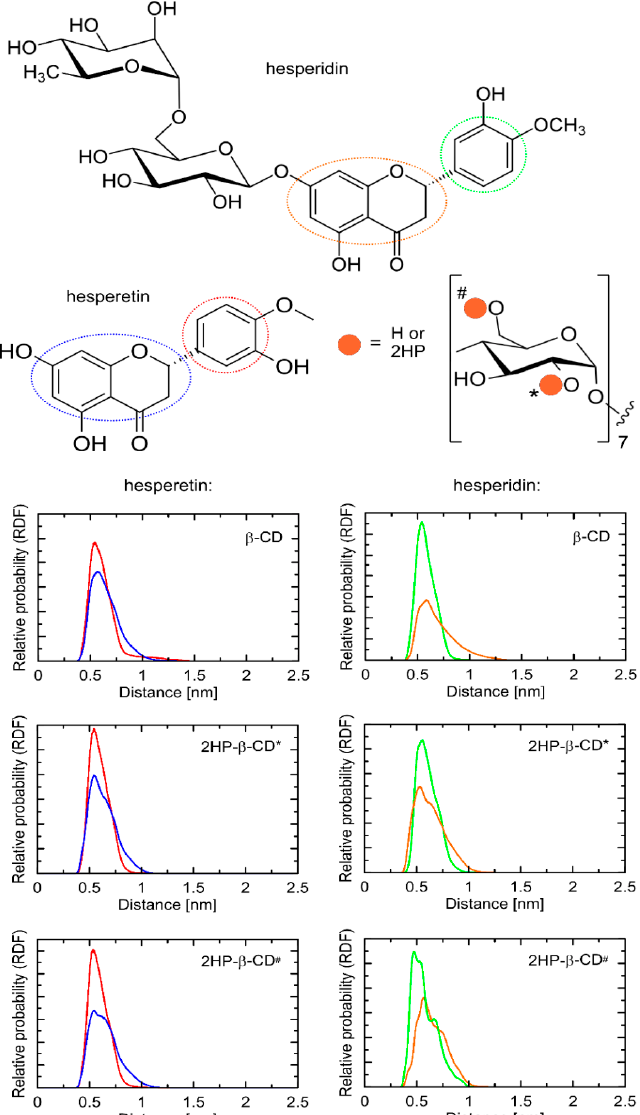
Figure 9. Radial distribution functions (RDFs) calculated for distances between selected fragments of the studied systems. Only the “anchoring site” of guest molecules was considered and split into two parts. In the case of hosts, the inner channel (aliphatic carbon atoms attached to glycosidic oxygen atoms) were the reference for calculating RDFs. The color code is maintained throughout the figure. 2HP- β -CD* denotes that all 2HP groups are substituted to the O(2) hydroxyl oxygen atoms of β -CD; 2HP- β -CD# denotes that all 2HP groups are substituted to the O(6) hydroxyl oxygen atoms of the hydroxymethyl groups present in β -CD.